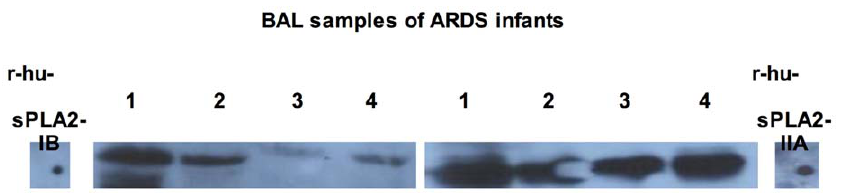
Figure 3. Western blot assay of BAL samples for the two main sPLA2 isotypes that respond differently to varespladib inhibition (sPLA2-IB and sPLA2-IIA). Illustrative results of four ARDS patients (and human recombinant proteins, as controls) are shown. All patients presents sPLA2-IIA, while some also shown the presence of the isotype –IB. sPLA2: secretory phospholipase A2.